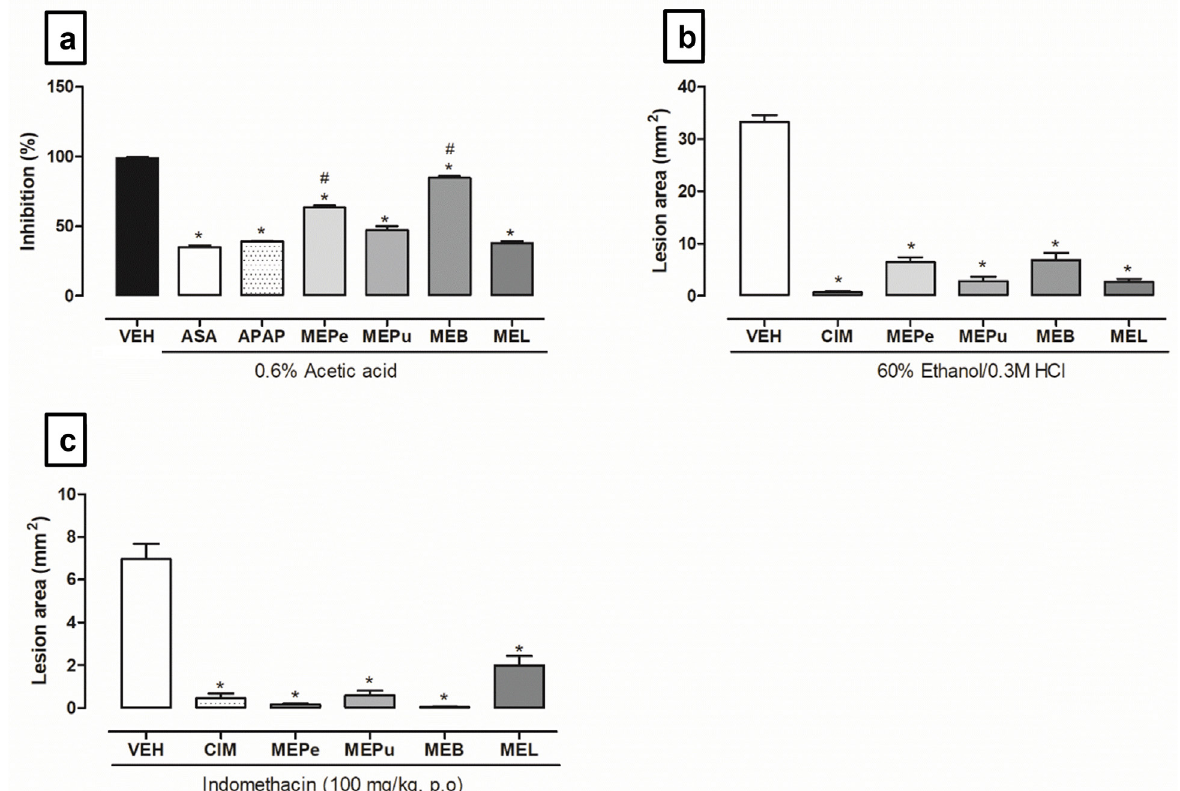
Figure 2. Antinociceptive (a) and gastroprotective effects against ethanol (b) and indomethacin (c) of the methanol extract from peels fruit (MEPe), pulp fruit (MEPu), branches (MEB) and leaves (MEL) of the A. selloana in mice. Results are presented as means ± S.E.M. (n=6). One-way ANOVA followed by Bonferroni test. * p <0.001 compared to the vehicle group # p <0.001 compared to the ASA or APAP group. VEH: vehicle (10% dimethyl sulfoxide solution), ASA: acetylsalicylic acid (10 mg/mL, i.p); APAP: acetaminophen (10 mg/mL, i.p); MEPu: methanolic extract from pulp fruit (10 mg/mL, i.p); MEPe: methanolic extract from peel fruit (10 mg/mL, i.p); MEB: methanolic extract from branches (10 mg/mL, i.p); MEL: methanolic extract from leaves (10 mg/mL,